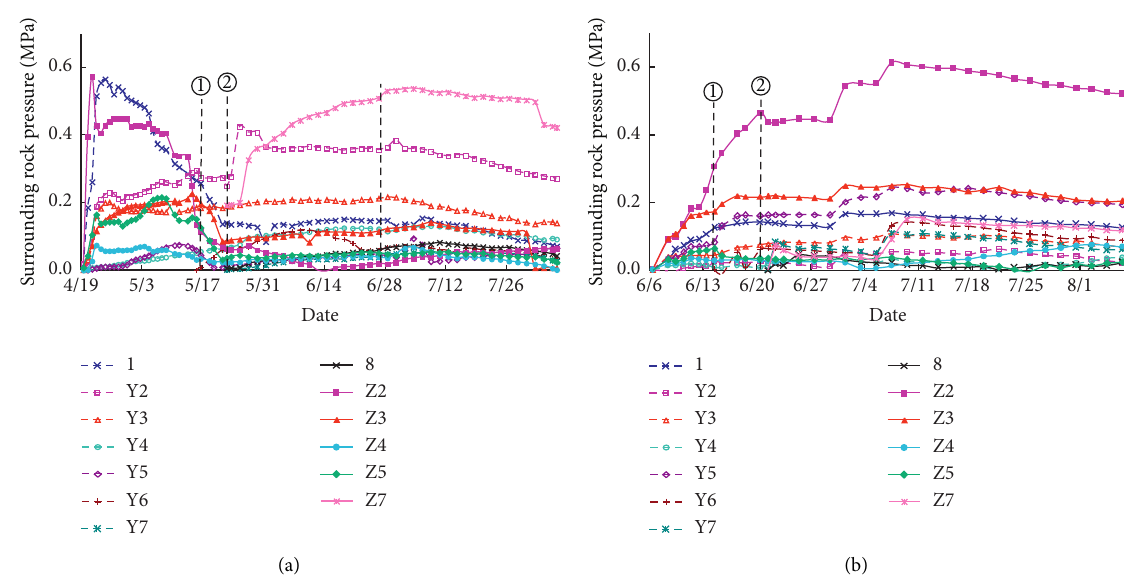
Figure 11: Time-history curves of surrounding rock pressure. (a) Section A. (b) Section C.